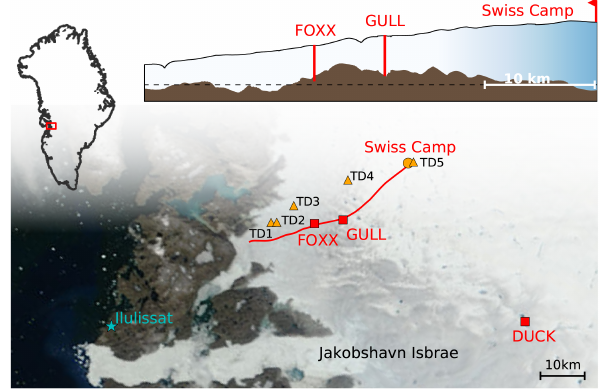
Figure 1. The study site indicated with red area within Greenland outline is illustrated with a MODIS satellite image provided by NASA/GSFC (2010). The drill sites FOXX and GULL are located on a flow line downstream of Swiss Camp, and north of Jakovshavn Isbræ. Site DUCK is from 1995 (Lüthi et al., 2002). Drill sites by Thomsen are marked with yellow triangles and indicated by TD1- 5. The inset shows bed and surface topographies along the flow line at 5-fold vertical exaggeration (data from DTU Space and Re- mote Sensing, 2005; Gogineni,